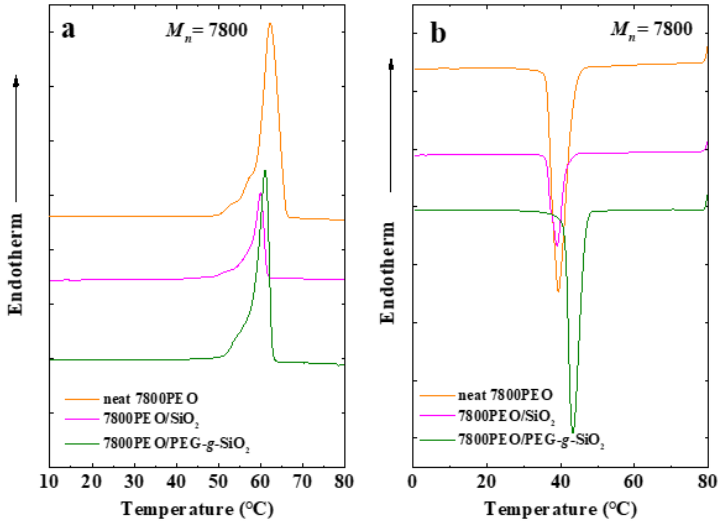
Figure A1. DSC heating ( a , b ) cooling scans of neat PEO, PEO/SiO 2 , and PEO/PEG-g-SiO 2 with a matrix molecular weight of 7800 g/mol.